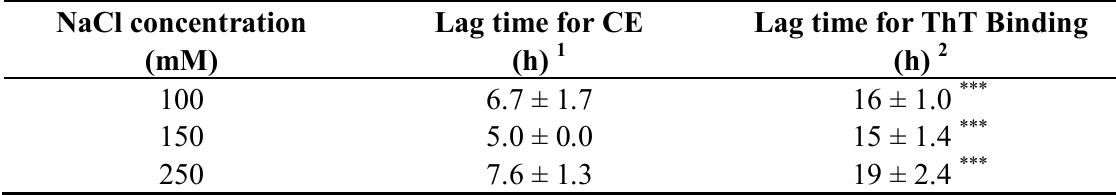
Table 1. Lag times observed at 100, 150, and 250 mM NaCl by CE versus ThT binding. NaCl